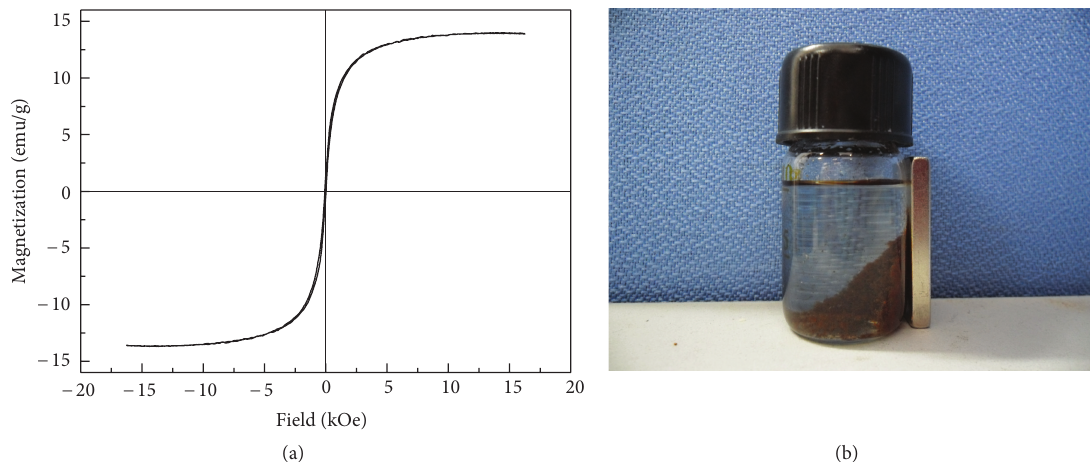
F 8: Hysteresis loop of the magnetic composite microcapsules at room temperature (a) and a photo picture to show the magnetic property of the magnetic composite microcapsules (b).